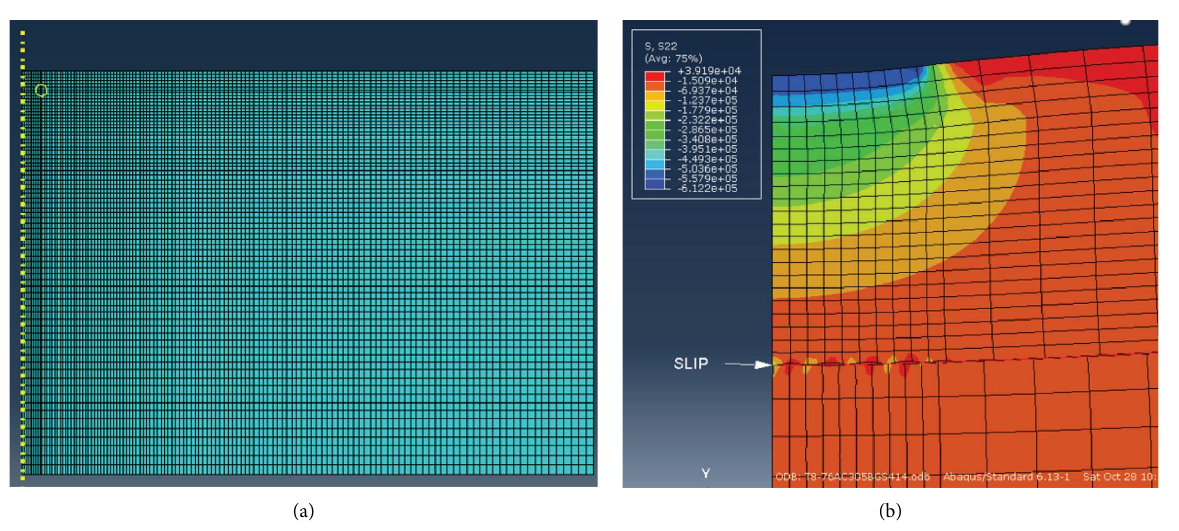
Figure 12: (a) 2D axisymmetric fnite element mesh and (b) typical interface